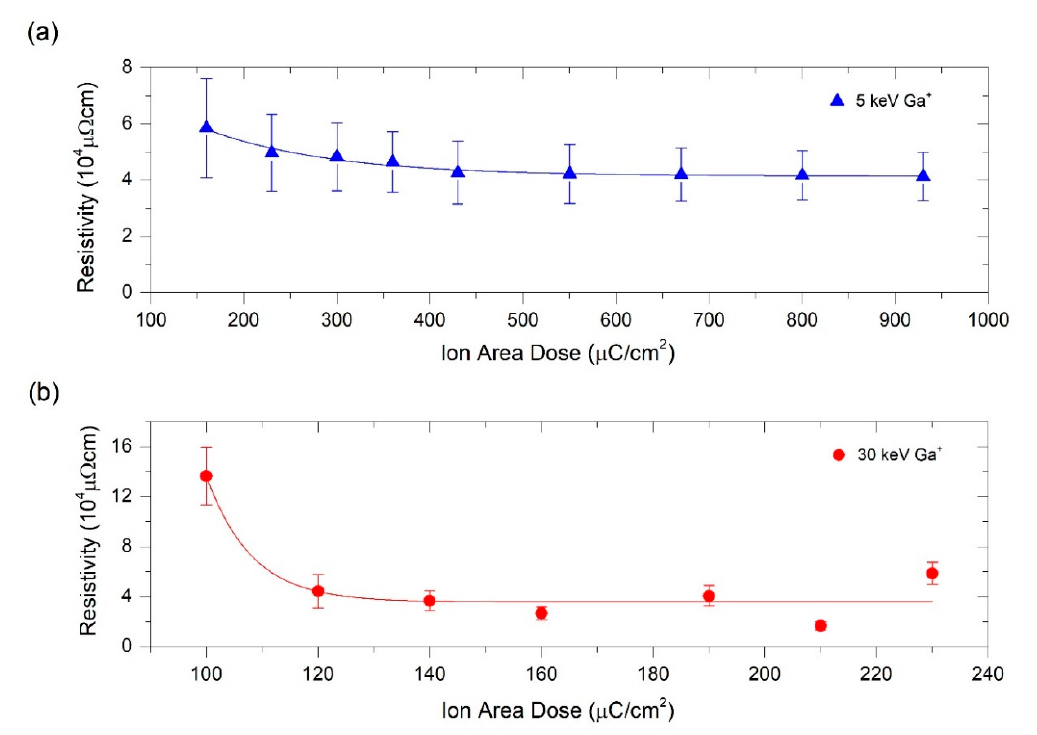
Figure 4. Electrical resistivity of Pt-C deposits as a function of the ion area dose used for their fabrication. ( a ) Resistivity values corresponding to deposits grown at 5 keV Ga + ; ( b ) Resistivity values corresponding to deposits grown at 30 keV Ga + . The main source of the error bar is the thickness indeterminacy owing to the ±3 nm precision of the profilometer.